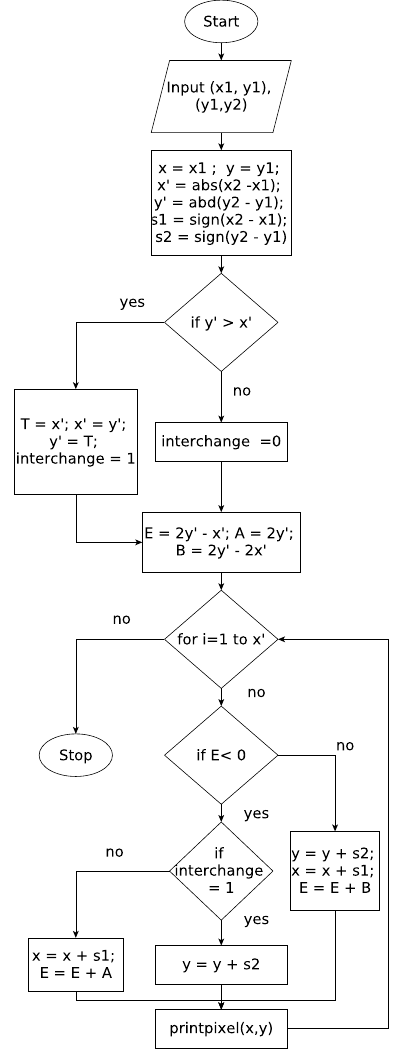
Figure 11. Bresenham’s line drawing